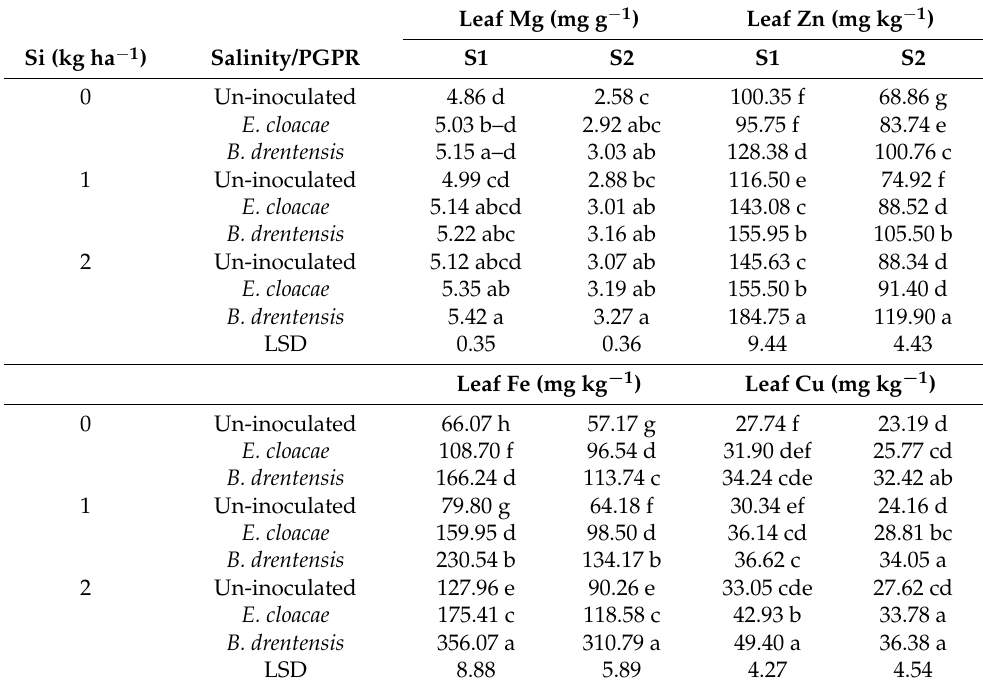
Table 2. Effect of silicon foliar spray and PGPR inoculation on mineral content of mung bean leaves under saline irrigation